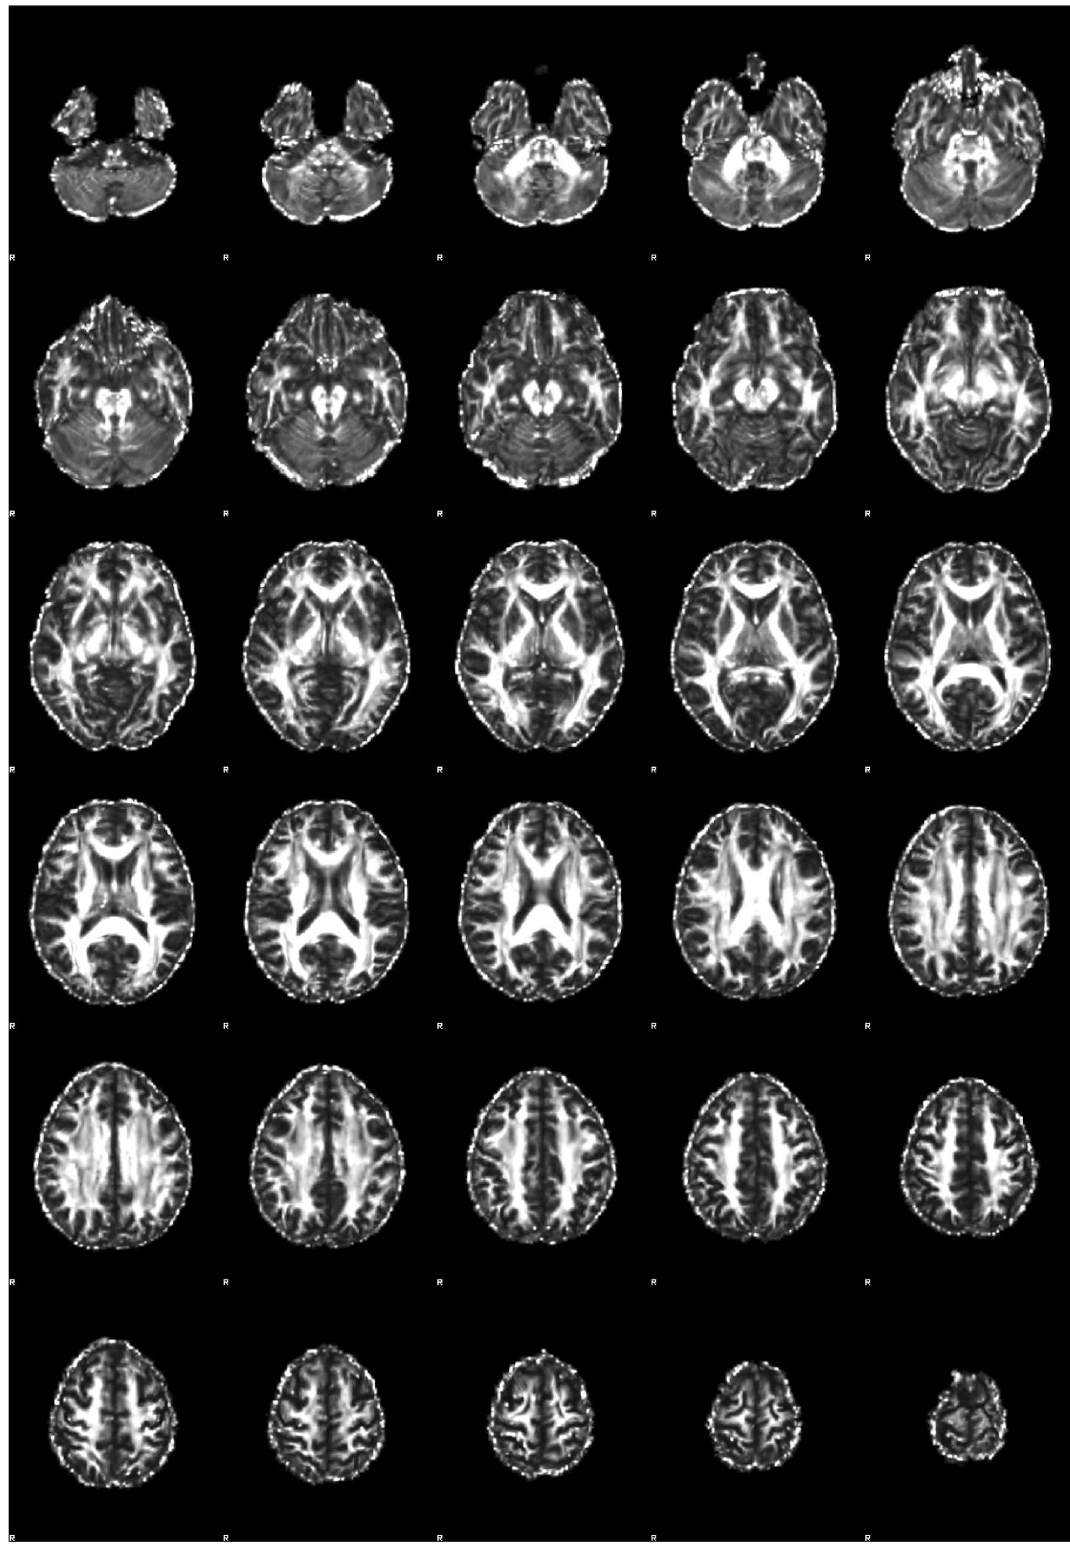
Figure 8. MRI slices of subjects with the largest